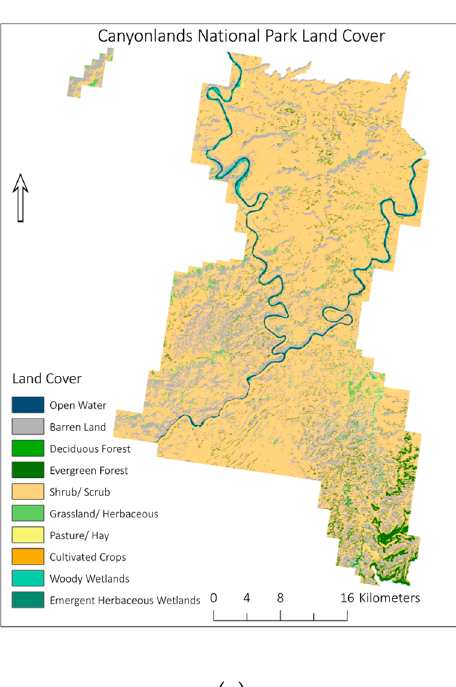
Figure 3. Everglades National Park Land Cover and Biomes North Cascades National Park in Washington is mountainous and home to hundreds of glaciers. The footprint of the mountain range is visible in Figure 4 & 5, which shows the land cover data of the park. The annual ecosystem service value of North Cascades National Park is $869,959,499 per year. It is the 12th-largest park by area in this study. North Cascades has one of the largest spatial extents of the “Forest” biome type out of all the National parks studied. The forest biome accounts for 50%